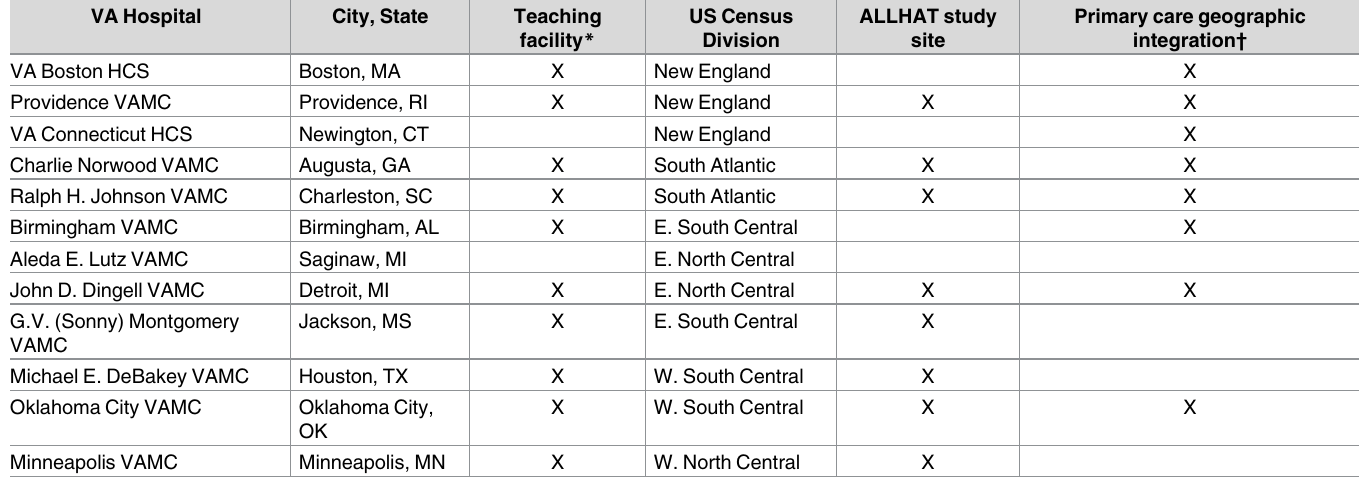
Table 1. Study-site